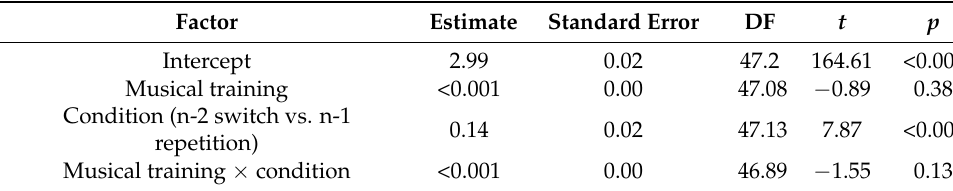
Table 1. Estimates for the mixed model on switch costs (dependent variable: reaction times). Factor